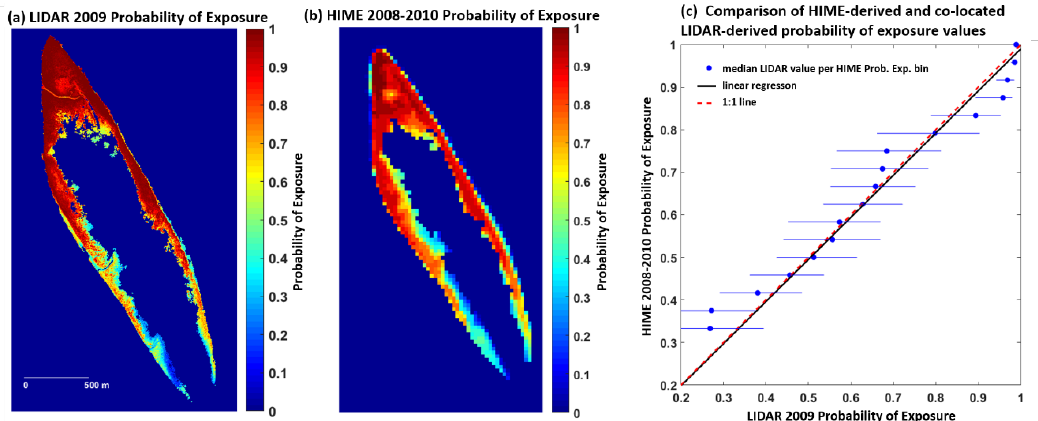
Figure 5. Validation of HIME exposure probabilities for Pintail Island. ( a ) LIDAR 2009 exposure probability map at 1 m pixel resolution. ( b ) 2008–2010 HIME exposure probability model at 30 m pixel resolution, masked to LIDAR extent. ( c ) Comparison of LIDAR-derived (X-axis) and spatially co-located HIME (Y-axis) exposure probabilities. Blue points are medians and blue horizontal bars are the interquartile ranges of the LIDAR 2009-derived exposure probability pixels that were co-located with the pixels of each of the n HIME exposure probability categories. Solid black line is linear regression, dashed red line is 1:1 line.